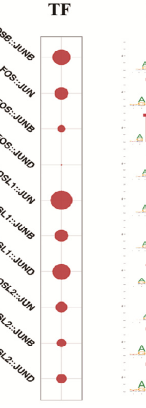
Figure 7. The top ten enrichment of the transcription factor motifs for different peaks between the CK and T groups. The ordinate is the TF name, and the abscissa is the comparison between two groups. The size of the circle represents the -log10 (E-value) of the corresponding TF motif.